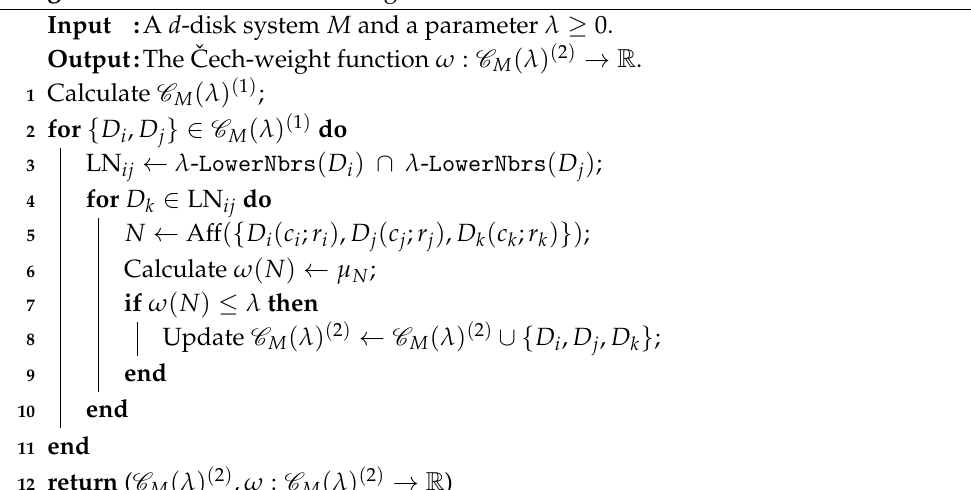
Algorithm 4: 2-skeletal ˇCech-weight